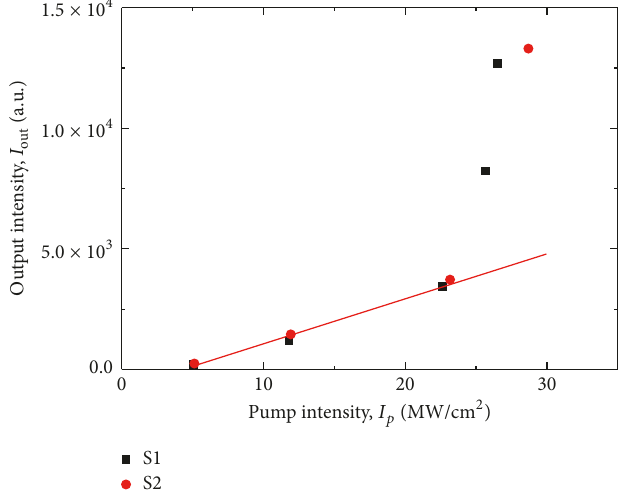
Figure 4: Input-output intensity dependence of S1 and